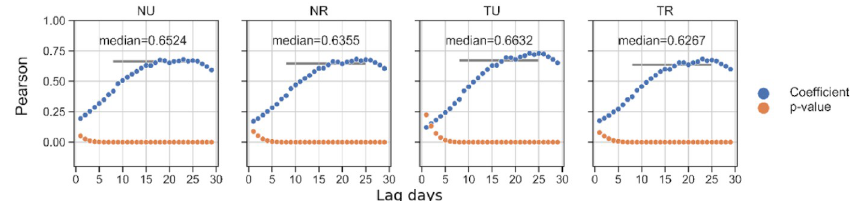
Fig 9. Pearson correlation over lag times. Clusters are shown for all SoCal counties excluding LA and OR, and follow the arrays shown in Fig 8. Lag times capture the possible time between exposure and positive testing. While the maximum correlation coefficient appears for all clusters at 24 days, we include the median of the reasonable lag range (gray bar) suggested by the CDC.